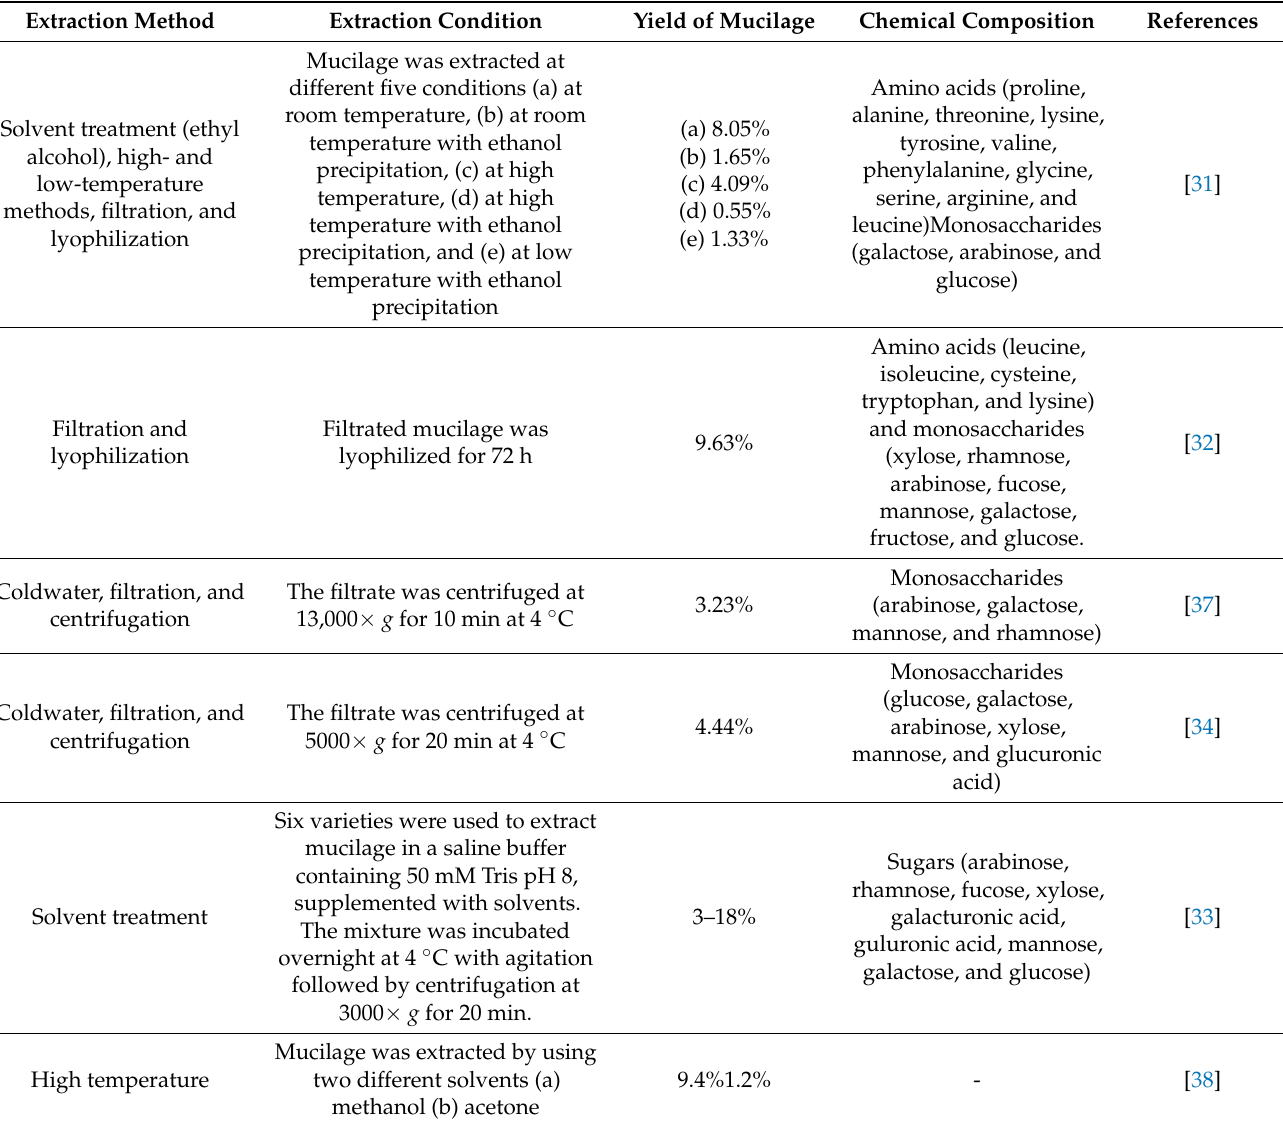
Table 1. Various extraction methods, yields, and chemical compositions of taro